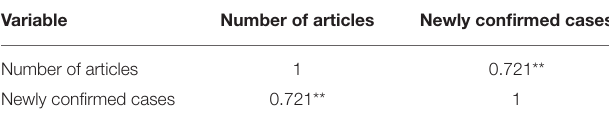
TABLE 4 | Pearson correlation coefficient.